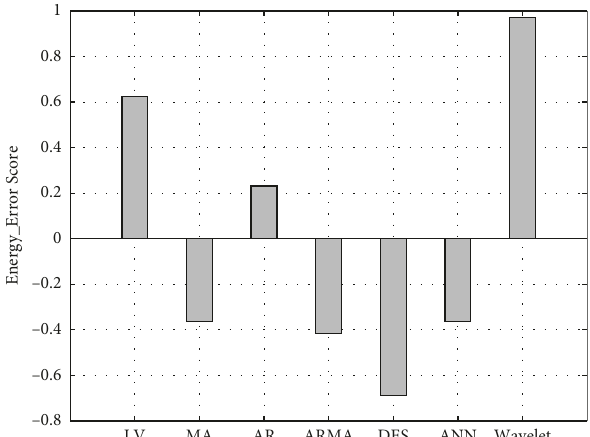
Figure 10: Energy_Error Score of traffic